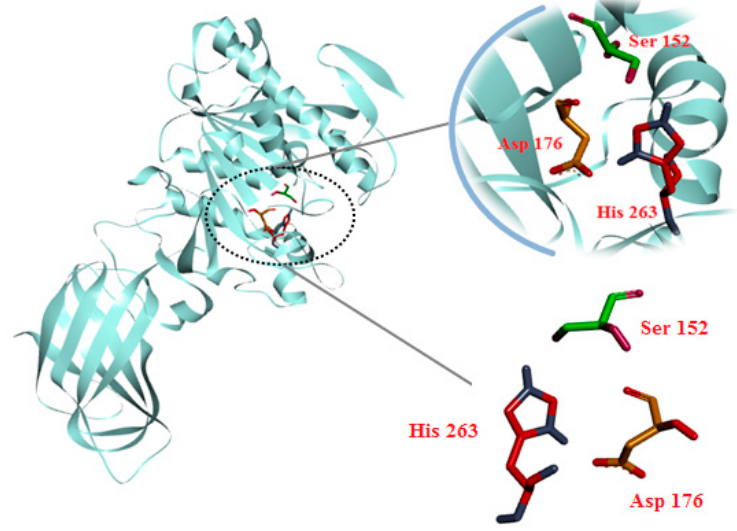
Three-dimensional structure of human pancreatic lipase and catalytic triad of Figure 1. Three ‐ dimensional structure of human pancreatic lipase and catalytic triad of Ser152 ‐ Ser152-Asp176-His263 (PDB ID: Asp176 ‐ His263 (PDB ID: 1LPB).